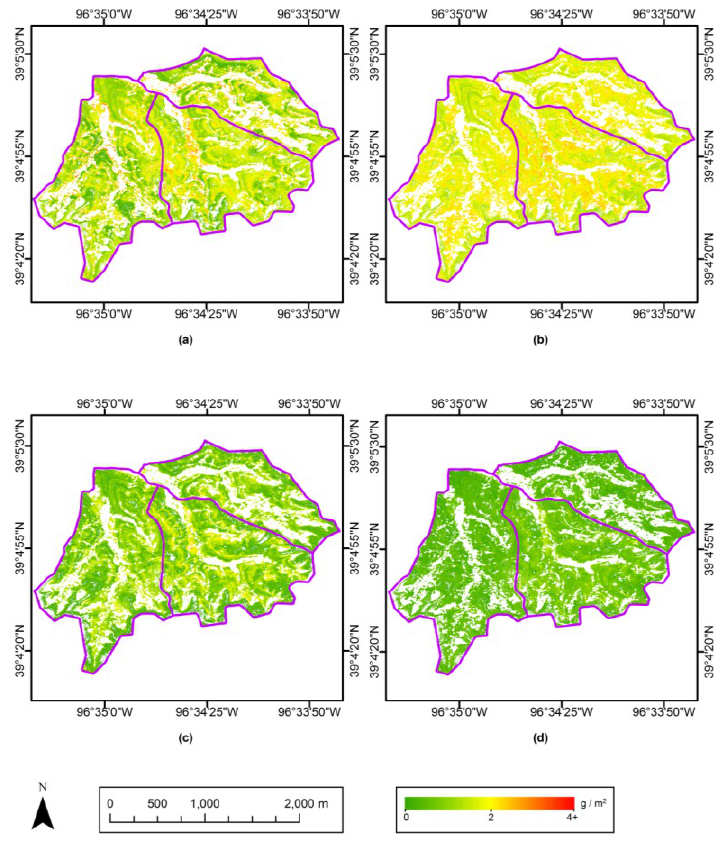
Figure 6. Maps of N can distribution in selected watersheds at KPBS in ( a ) May, ( b ) July, ( c ) August, and ( d ) September. White areas are where gallery forest pixels were masked prior to